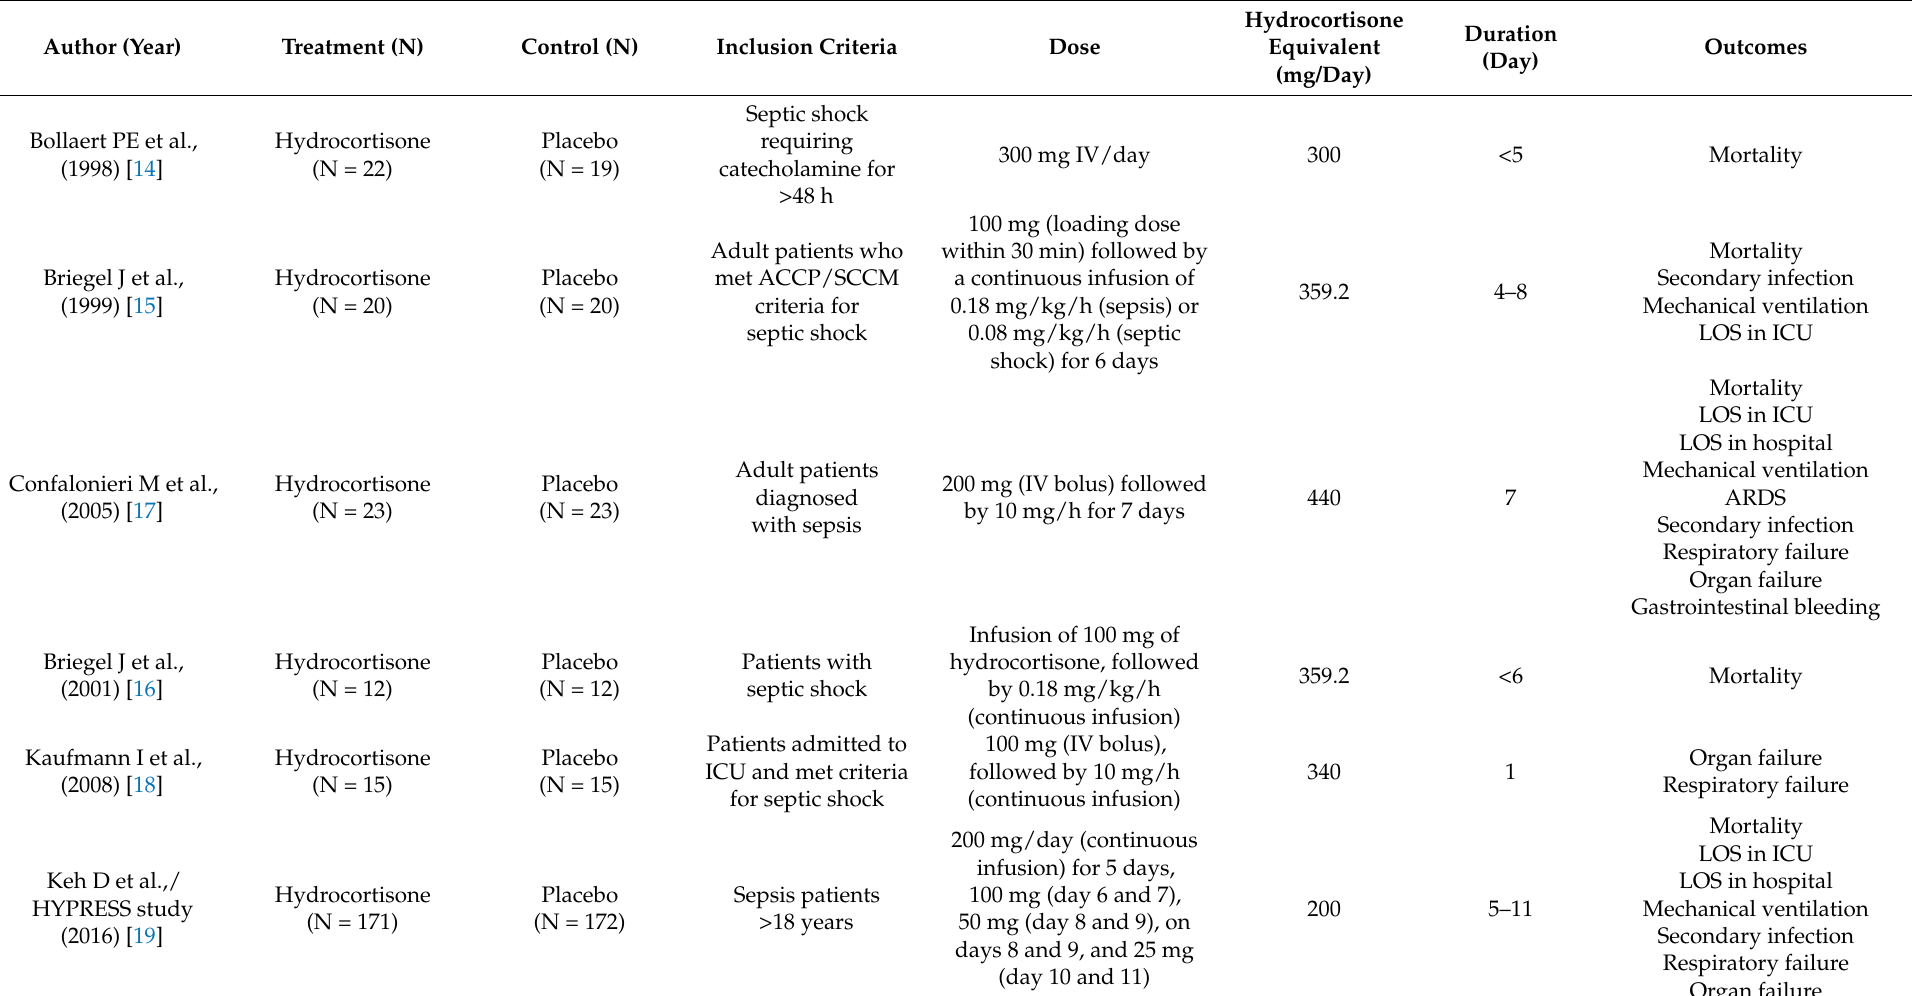
Table 1. Characteristics of the 21 clinical trials included in the meta-analysis on clinical outcomes of